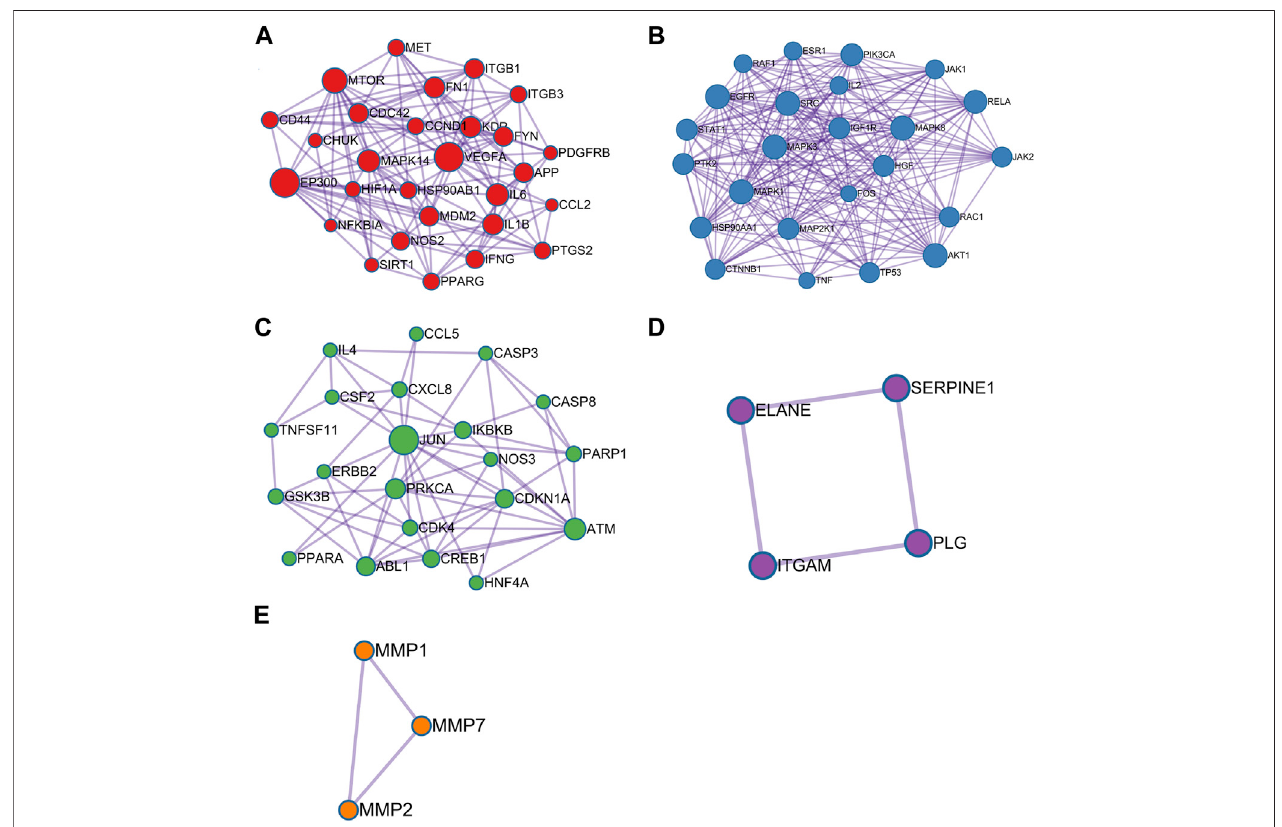
FIGURE4| Moduleanalysisof115criticalgenesisperformedbytheMetascapetool.Eachmoduledemonstratsdifferentbiologicalprocessfunctions. (A) Module 1; (B) Module 2; (C) Module 3; (D) Module 4; (E) Module 5.